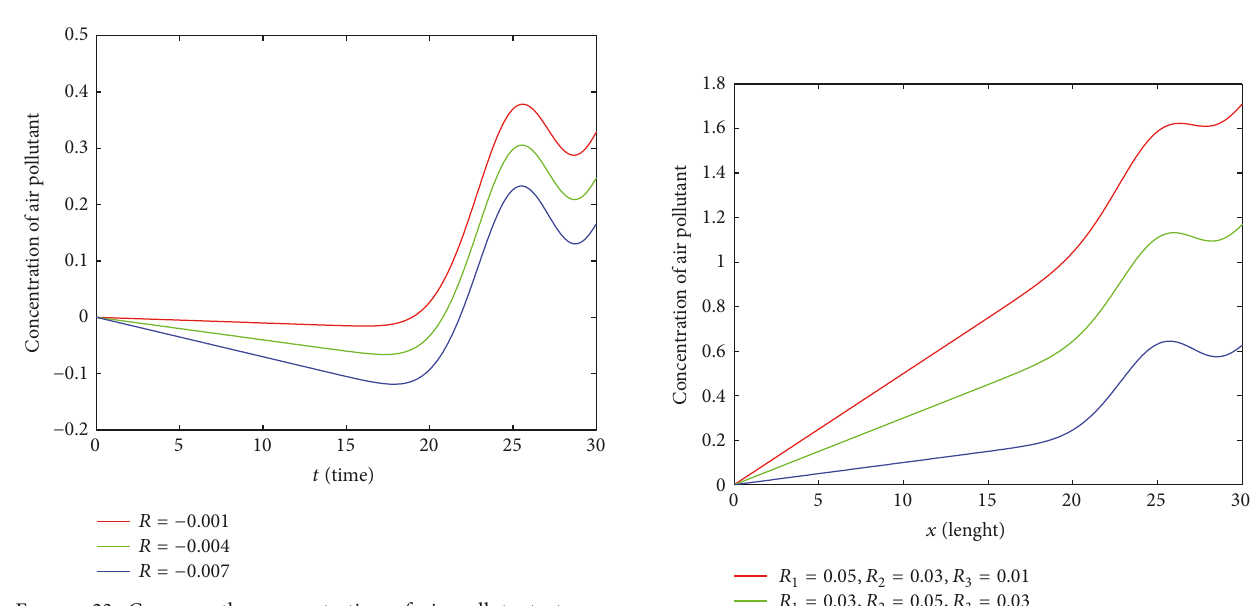
Figure 24: Compare the concentration of air pollutant at 𝑥 = 60 m , 𝑦 = 14 m , 𝑧 = 4 m of moving sources (vehicle sources) in different time.